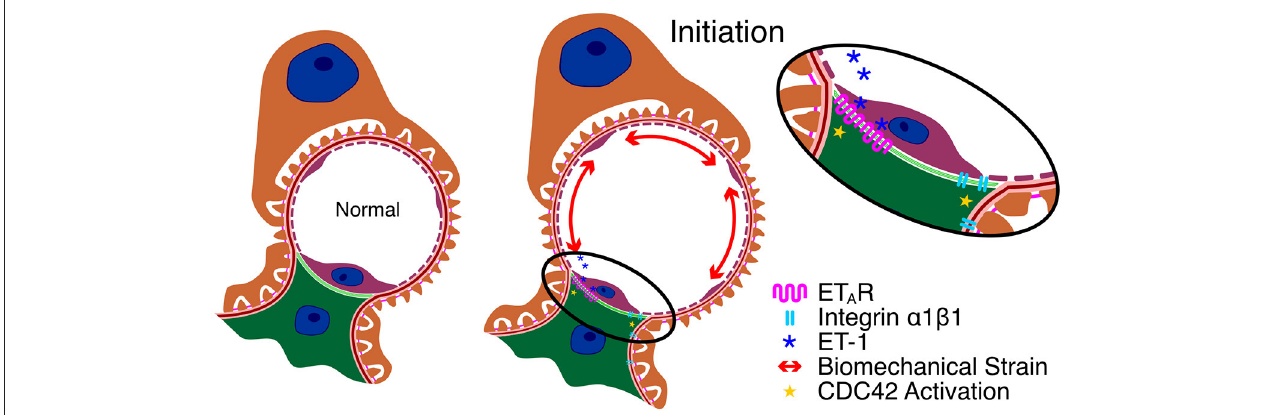
FIGURE 1 | Key aspects of Alport glomerular disease initiation. Due to the change in basement membrane composition, the GBM in Alport syndrome is thinner and more elastic, resulting in increased capillary diameter and biomechanical strain on the cells that adhere to the capillary. This results in elevated expression of ET-1 in the endothelial cells which activates ET A Rs on mesangial cells resulting in CDC42 activation. Blockade of integrin α 1 β 1 on mesangial cells prevents ET A R-mediated CDC42 activation and thus prevents initiation through an unknown